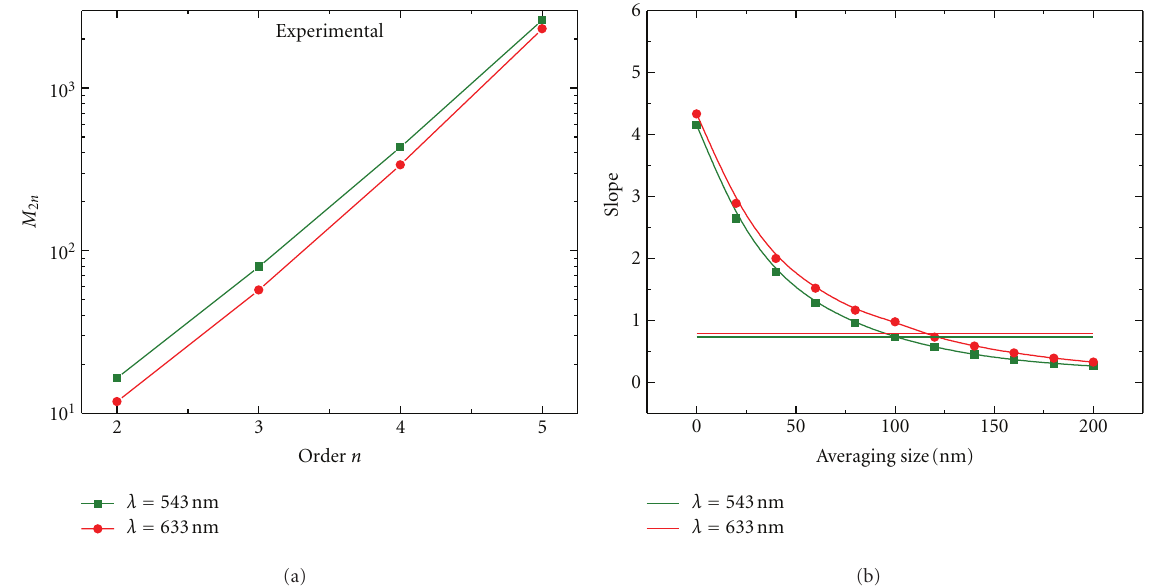
Figure 5: (a) Log-linear plot of measured high-order moments of near-field intensity enhancement M 2 n versus n . (b) Slope of log( M 2 n ) over n at the percolation threshold obtained numerically after spatial averaging versus averaging parameter d . The measured slopes are marked by horizontal lines with the standard error given in the legend [22, Figure 3].